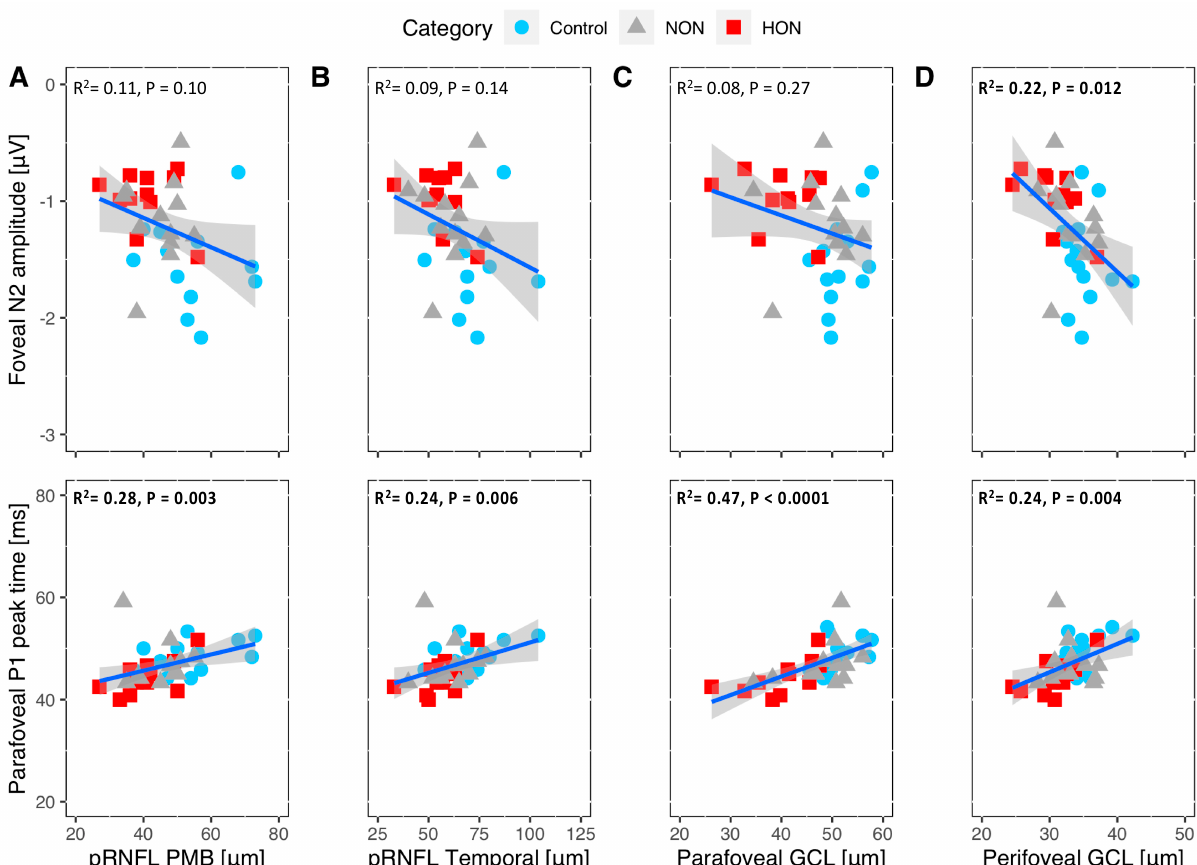
Figure 3. Association of foveal (ring1) N2 amplitude of the mfPERG reflecting RGC axon integrity (top row) and of the parafoveal (ring 2) P1 peak time of the mfPERG reflecting RGC body integrity (bottom row) vs. relevant structural tests. The y -axis is N2 (ring1) amplitude in the top row and P1 (ring2) peak time in the bottom row. A and B x axes: peripapillary retinal layer thickness at the papillomacular bundle sector (pRNFL PBM) and temporal sector (pRNFL T). C & D x axes: parafoveal and perifoveal ganglion cell layer thickness (GCL). Significant associations highlighted in bold.